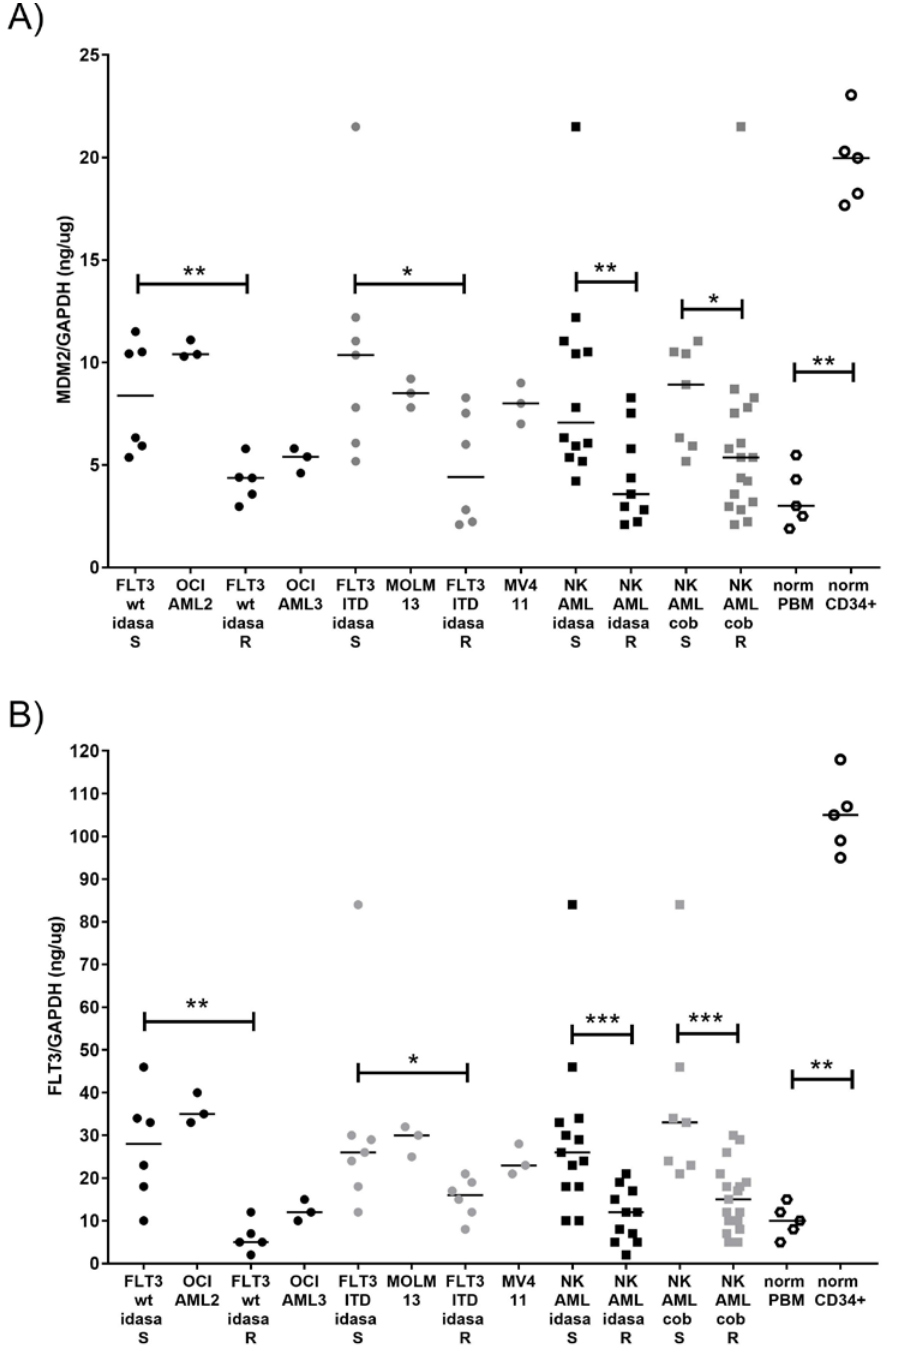
Figure 6. MDM2 and FLT3 protein levels correlate with treatment response in AML cell lines and patient samples. MDM2 ( A ) and FLT3 ( B ) protein levels as determined by ELISA and normalized to GAPDH. AML blast cells were grouped according to molecular subtypes (FLT3/TP53) and according to response rates. Sensitive AML cells were defined as having less than 80% cell viability after 24 h treatment with 1 µM idasanutlin (idasa-S) or 50 nM cobimetinib (cob-S). * indicates significant p -values in Mann-Whitney test. FLT3wt (black circles), FLT3-ITD (grey circles), NK-AML idasanutlin response (black squares), NK-AML cobimetinib response (grey squares), normal PBM (hexagons) and normal CD34+ cells (open circles). Significance is denoted for p < 0.05 (*); p < 0.005 (**); p < 0.0005 (***) .